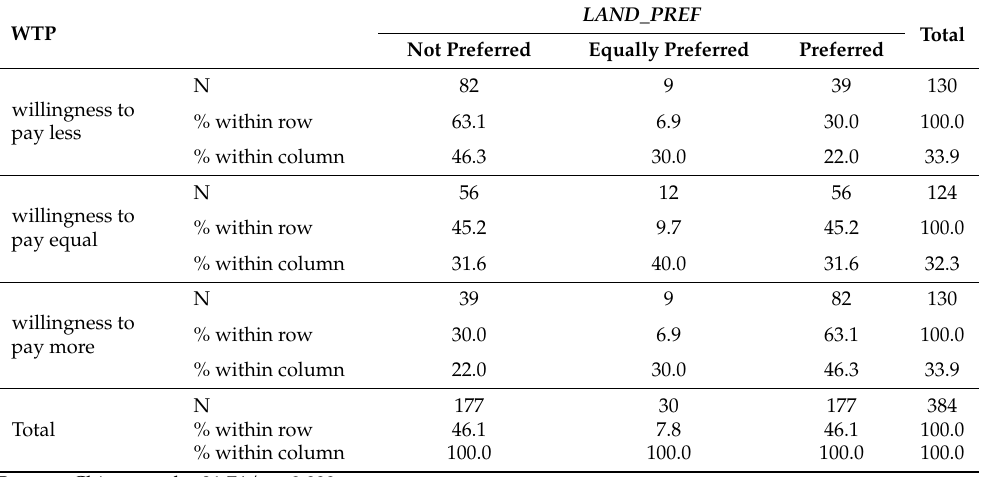
Table 6. Willingness to pay more for one of the tasted juices (WTP) and preferred landscape ( LAND _ PREF